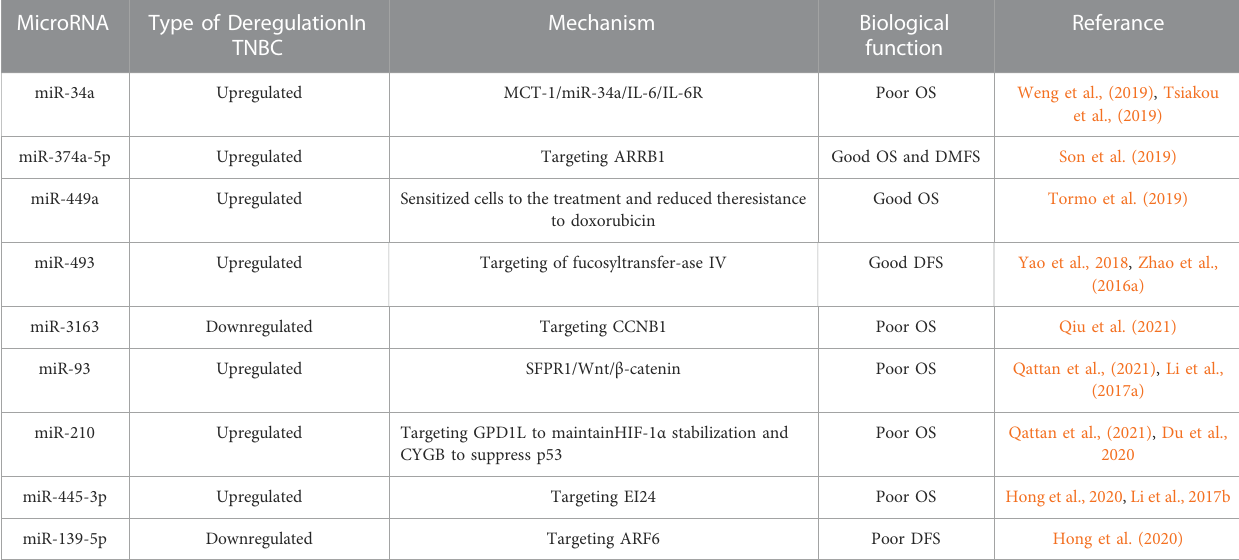
TABLE 2 Abnormal expression of MicroRNAs that can judge